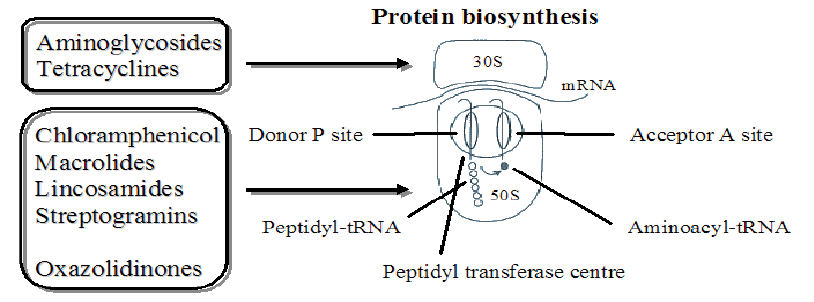
Figure 6. The process of protein biosynthesis can be inhibited by compounds targeting the 30S or the 50S subunit of the bacterial